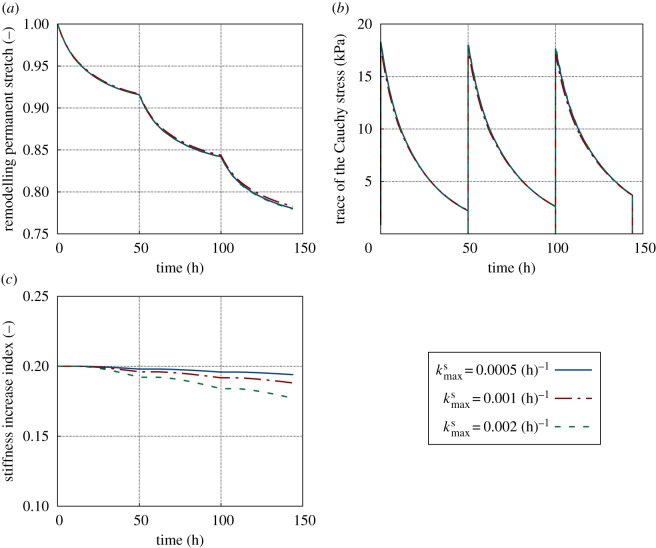
Remodelling permanent stretch, ϑ (a), trace of the Cauchy stress, tr σ (b) and stiffness increase index, Deff (c), at a representative Gauss point of the inner cavity wall. Evolution through three foam changes (at 0, 50 and 100 h) considering a value kmaxs in the rate of stiffness increase ks(ϕ) of 0.0005, 0.001 or 0.002 (h)−1.